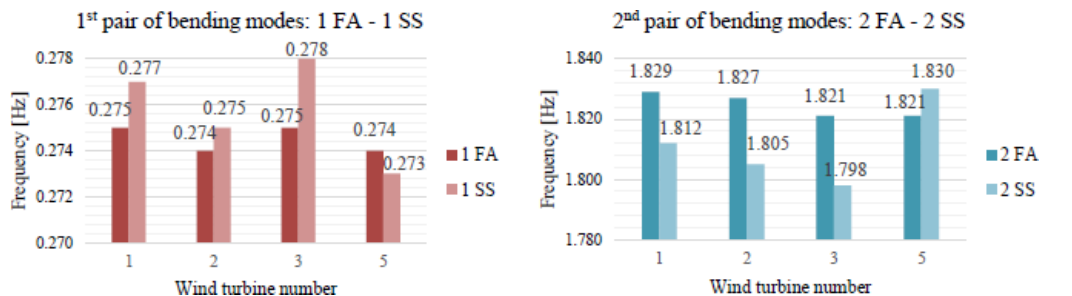
Figure 7. Comparison of the natural frequencies of four wind turbines in non-operational conditions (first and second pairs of bending